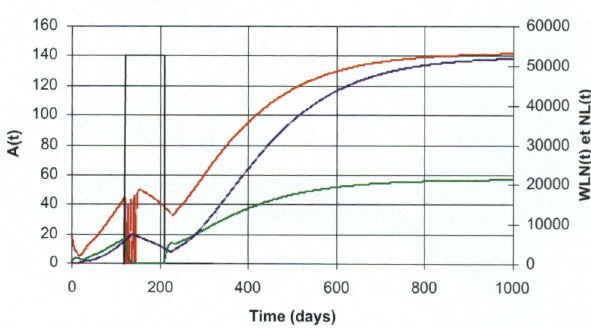
Fig. 17. - Trial combining non-persistent insecticide + oral IGR on host animal: use of non-persistent insecticide three days running each week for one month, with parallel oral administration of IGR for three